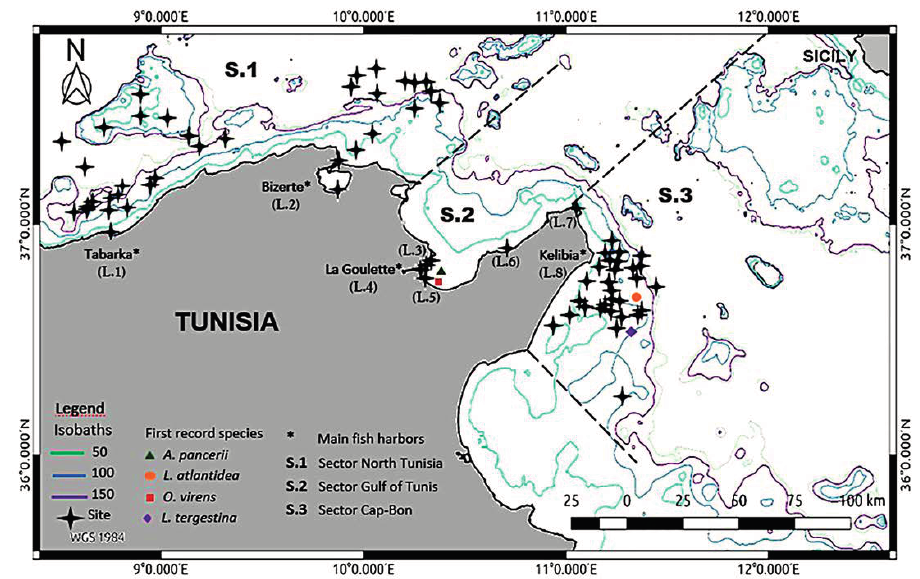
Fig. 1. – Map of the locations (L.) in northern Tunisian waters sampled for echinoderms, also showing the sites of new records: Asterina pancerii (green), Luidea atlantidea (orange), Ophiactis virens (red), Leptopentacta tergestina